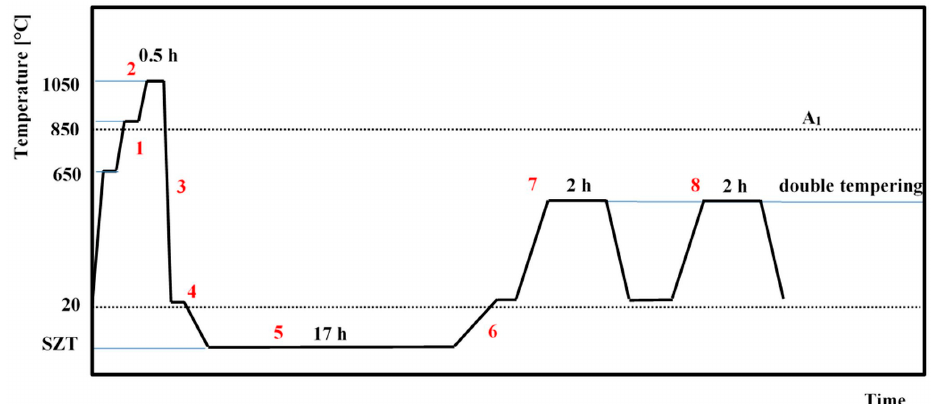
Figure 1. A schematic of heat treatment schedules applied for conventional heat treatment (CHT) and sub-zero treatment (SZT).